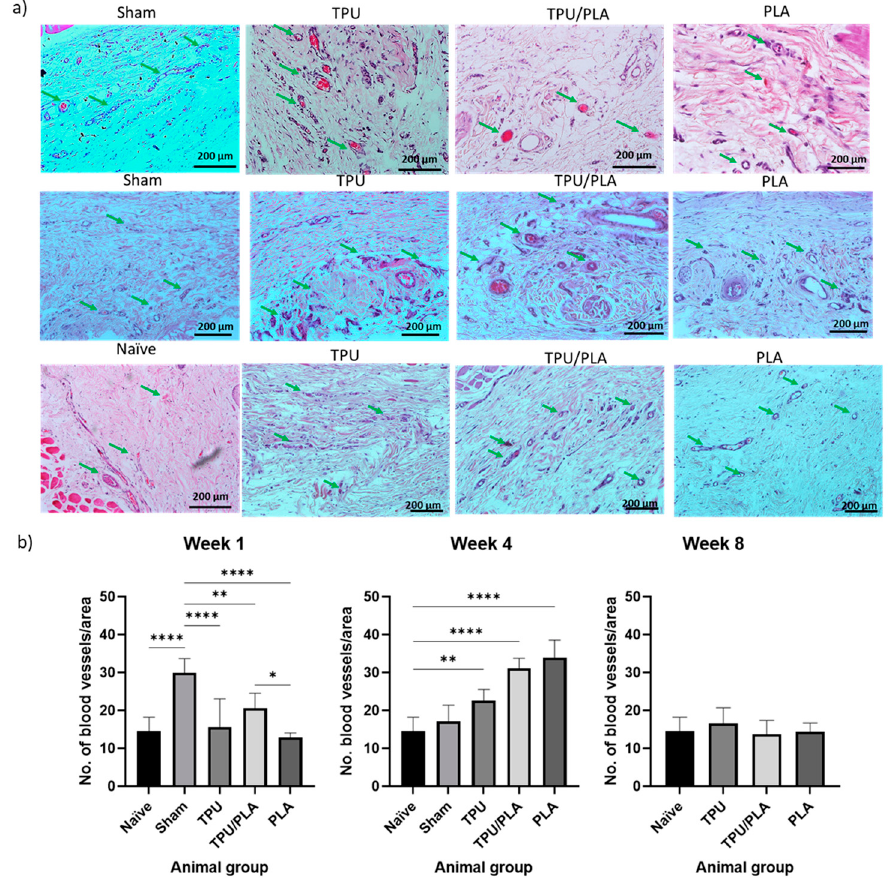
Figure 8. ( a ) Vascularisation of the tissue adjacent to the implanted scaffold at week 1. H&E staining shows blood vessels in the tissue adjacent to the implanted scaffold. The green arrow indicates the blood vessels. The highest number of blood vessels was observed in the sham and PLA groups. ( b ) Semi-quantitative analysis of vascularisation at different time points. Week 1, week 4, and week 8. The X -axis represents the grouping of animals, and the Y -axis represents the number of blood vessels per area. Compared to the naïve group, vascularisation at week 1 showed minimal changes in both the TPU and PLA groups, while it was significantly the highest in the sham group. However, a significant increase was observed in week 4, which was highest in PLA, followed by the TPU/PLA blend, and TPU. Finally, vascularisation was almost back to baseline at week 8. One-way ANOVA with Tukey’s multiple comparison tests was used for comparison between groups. Data are presented as mean ± SD, n = 2 animals per group, * p < 0.05, ** p < 0.01 **** p <